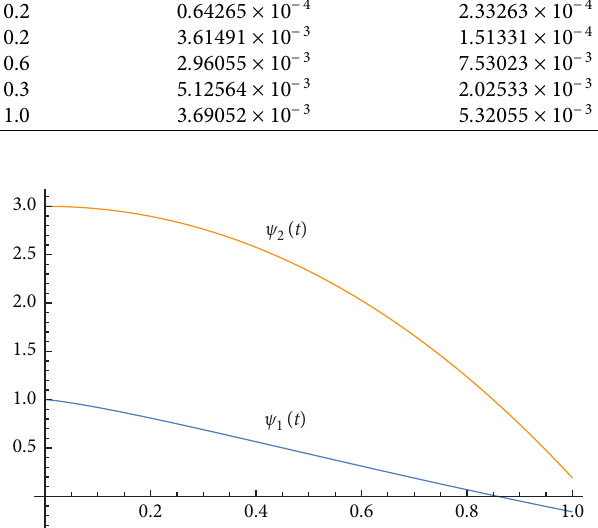
Figure 2: Graphs of the approximated solutions ψ for Case